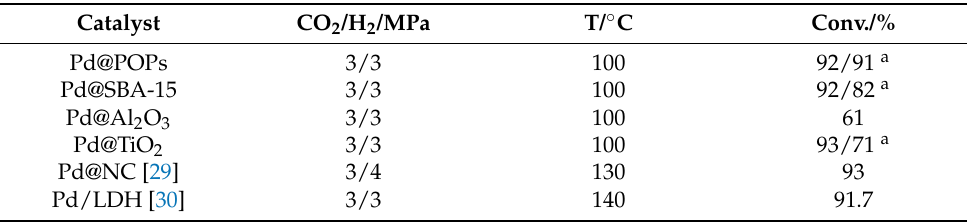
Table 2. Comparison of the catalytic performance of Pd@supports.